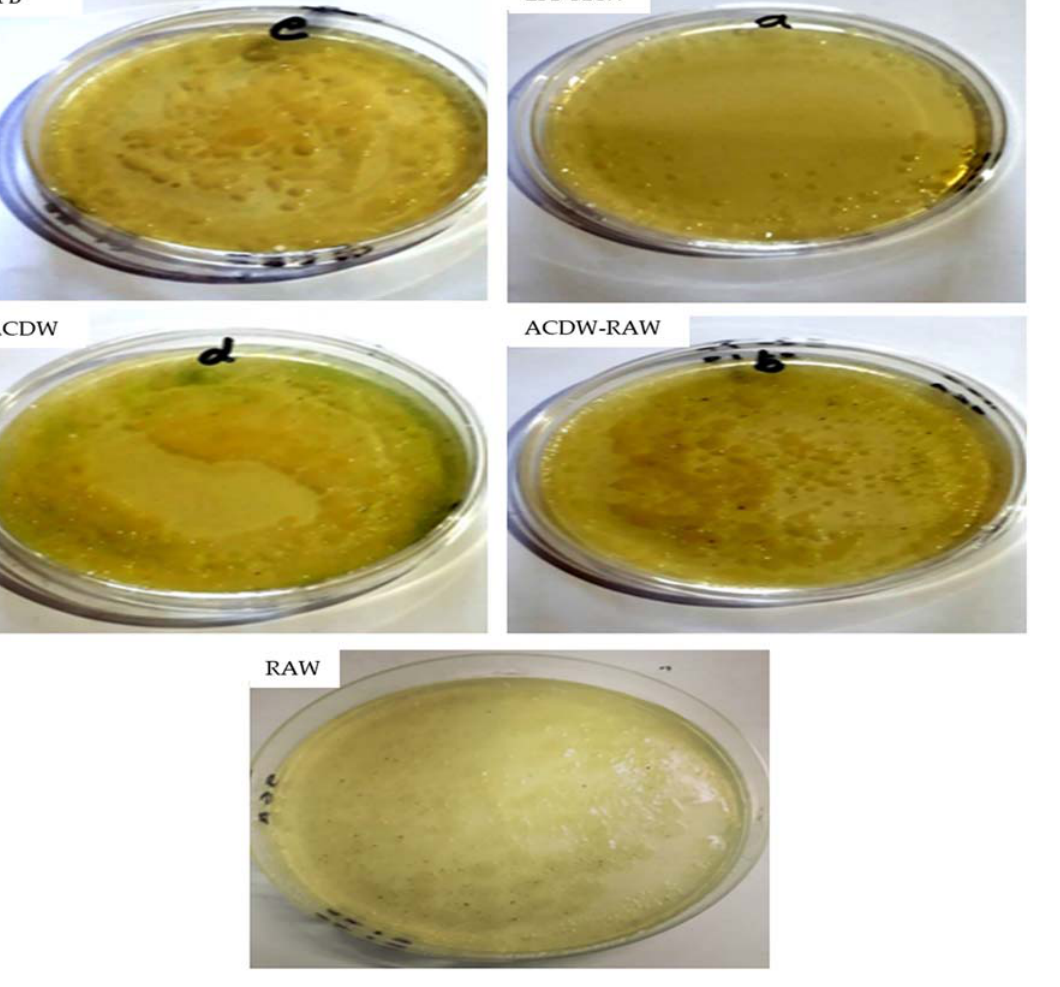
Figure 12. Bacterial count on agar media of all groups: LFB: lipid-free biomass, LFB-RAW: real aquaculture wastewater treated with LFB, ACDW: Arthrospira complete dry weight, ACDW-RAW: real aquaculture wastewater treated with ACDW, RAW: real aquaculture wastewater. Table 4. Bacterial count as a result of treatment of real aquaculture wastewater using LFB and ACDW.